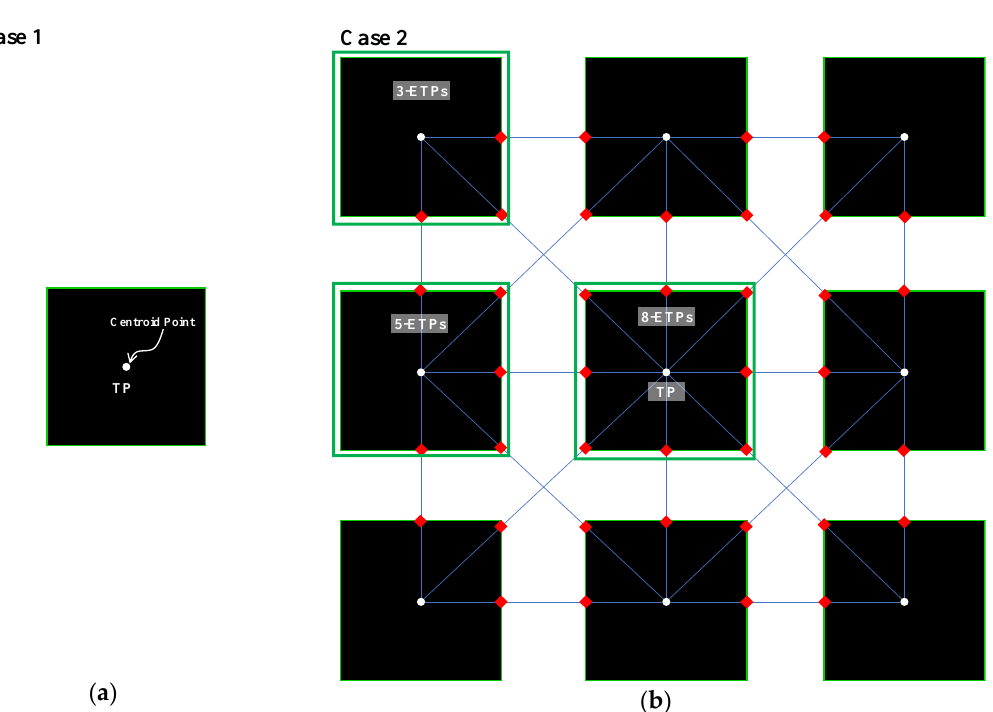
Figure 5. Two target tracking methods: ( a ) TP, ( b ) expanded TPs.